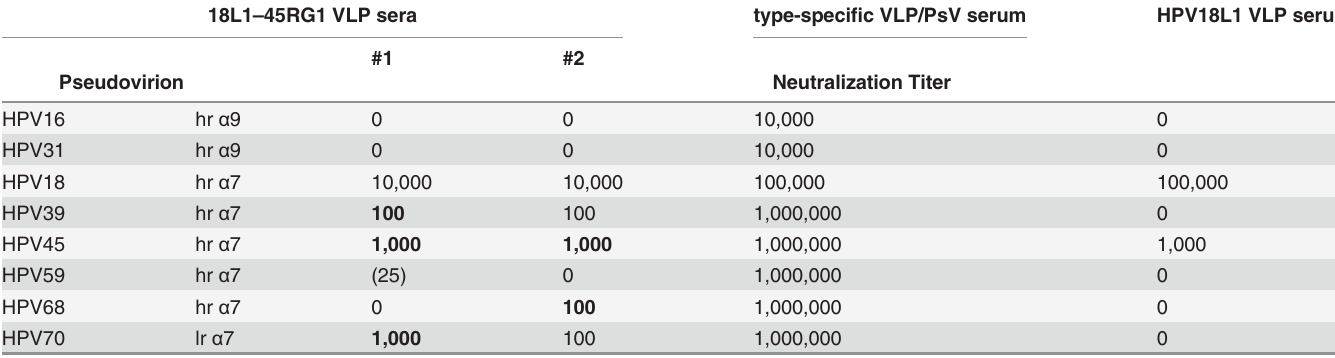
Table 2. In vitro cross-neutralization of α 7 mucosal hr and lr HPV by antisera raised against 18L1 – 45RG1 VLP using L2-based pseudovirion neutralization